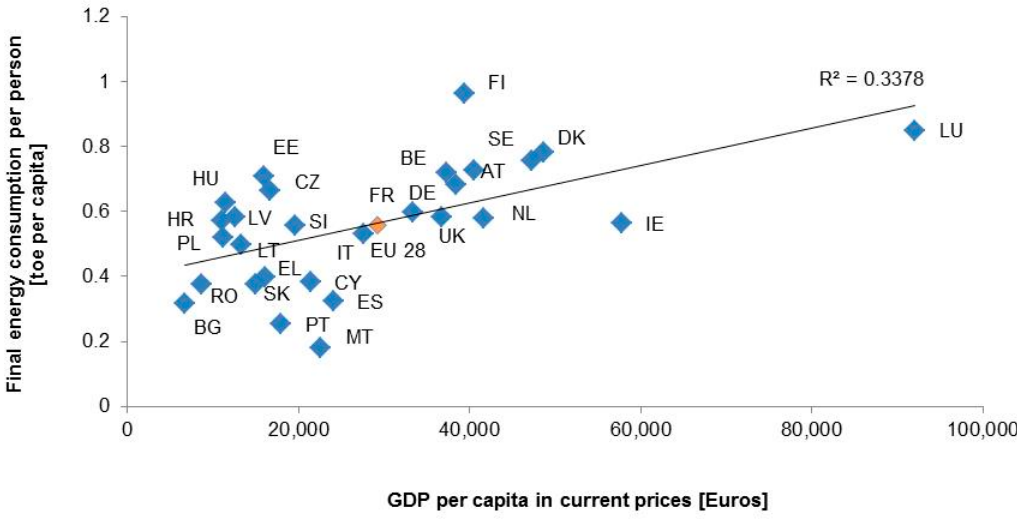
Figure 15. Correlation between GDP per capita and residential energy consumption per capita in the EU-28 member states, 2016. Source: Eurostat.